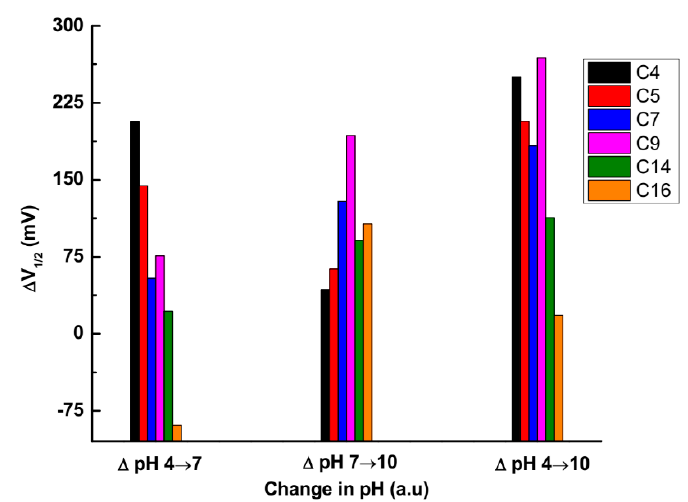
Figure 3. Comparison of change in E onset ( ∆ V) values for conductivity curve of poly(C n -EDOT-COOH)s while changing pH of an aqueous bu ff er from pH 4 to pH 7, pH 7 to pH 10, and pH 4 to pH 10 (the ∆ V values are shown in Table 1).